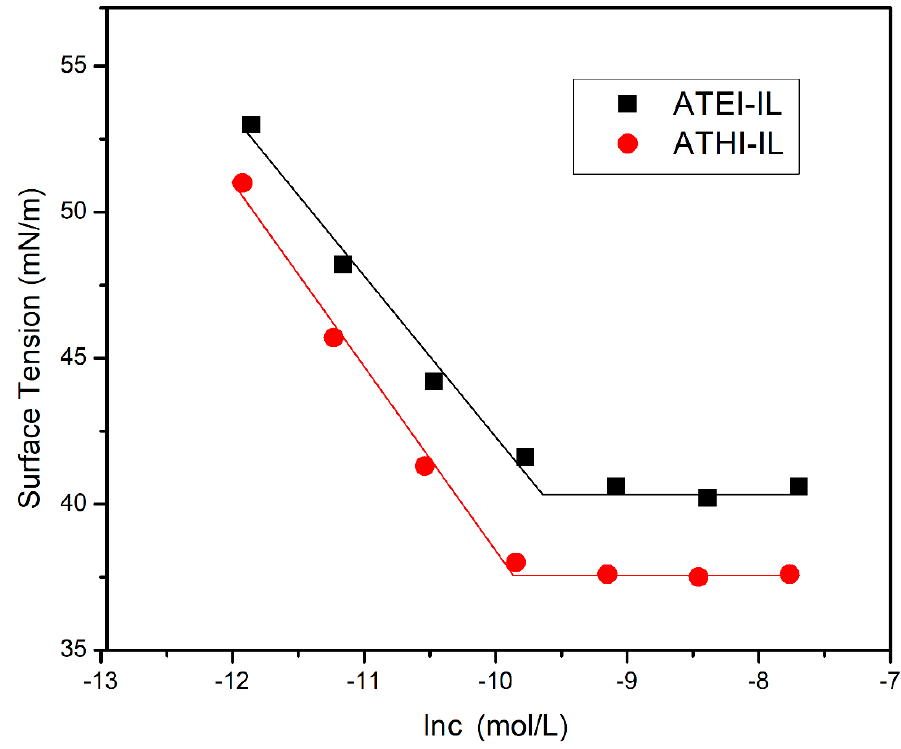
Figure 4. Surface tension variation with different aqueous concentrations of ATHI-IL and ATEI-IL at 25 °C.